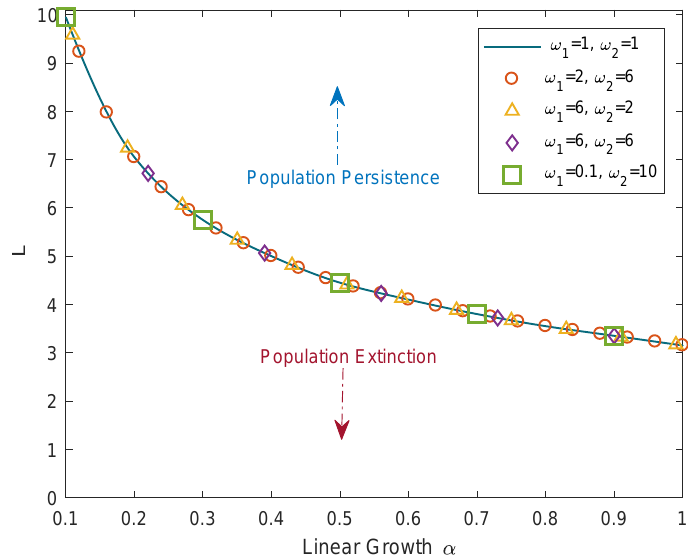
Figure 1. Critical domain size of the reaction–telegraph equation obtained numerically at various values of linear growth rate α and various values of ω 1 and ω 2 as shown by different symbols and different colors. The solid blue curve corresponds to Equation (28). For parameters from below the curve, the population goes to extinction; for parameters from above the curve, the population exhibits unbounded